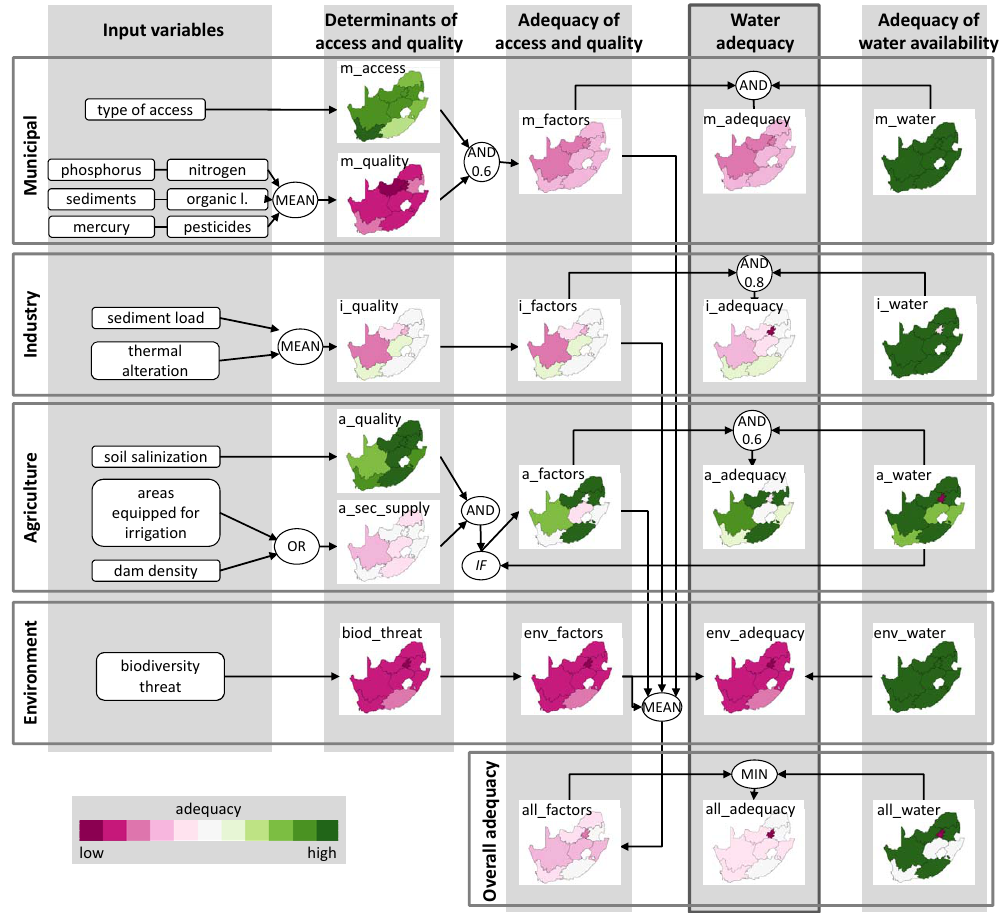
Figure 3. Fuzzy aggregation tree to calculate the adequacy of available water resources. Maps show values for South Africa using water availability data from the HadGEM2-ES model under current conditions